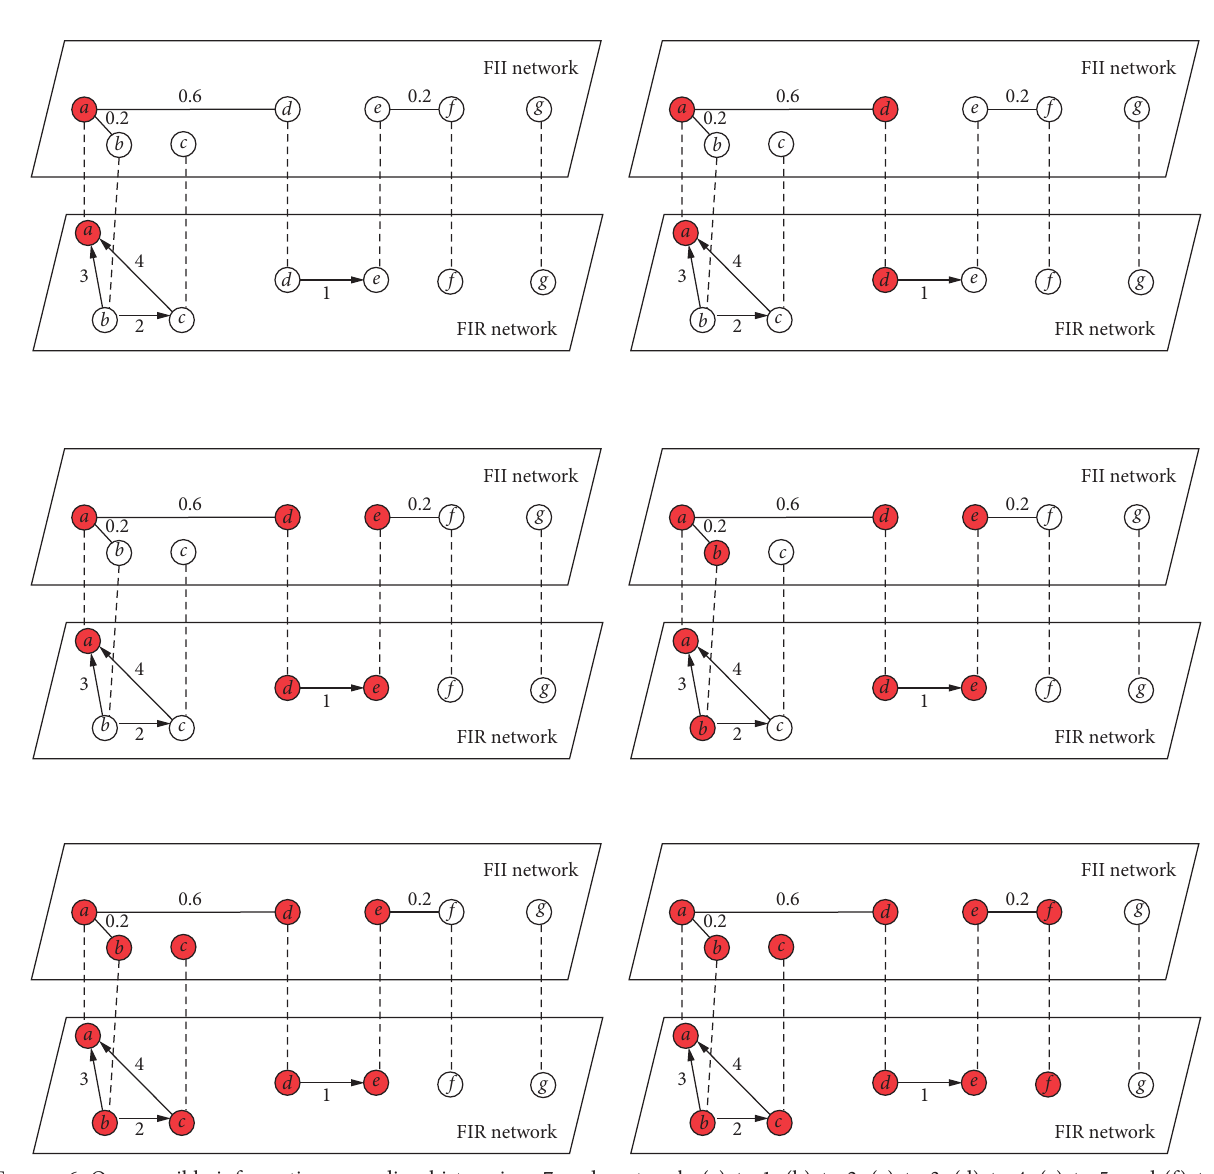
Figure 6: One possible information-spreading history in a 7-node network: (a) t � 1, (b) t � 2, (c) t � 3, (d) t � 4, (e) t � 5, and (f) t � 1. Table 3: Mean and standard deviations of spreading rate of each node in Figure